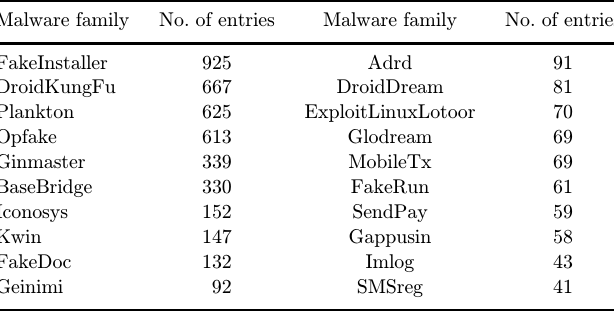
Table 1. Top 20 malware families of DREBIN